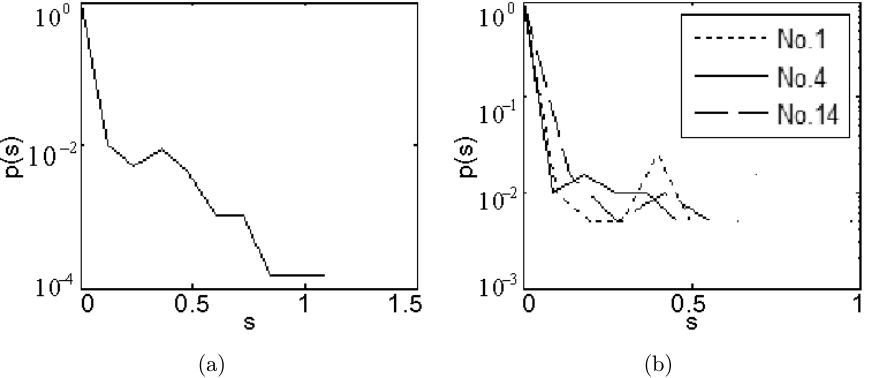
Fig. 2. A total of 34 sparse components obtained from the neuronal database, showing both high sparsity and bimodality. (a) Histogram of the activity of the source component matrix. (b) Histograms of the activities of three components.